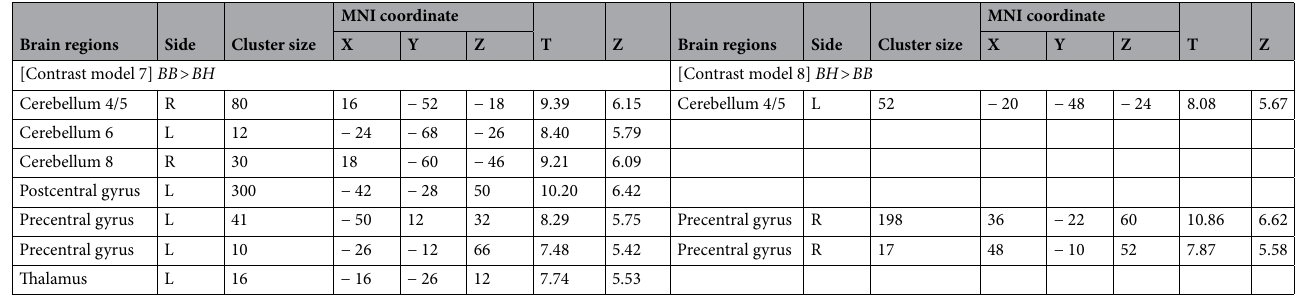
Table 3. MNI coordinates of results for contrast model 7 and 8. Row orders was sorted in alphabetical order with a few vacant rows to maximally visualize difference of two contrast models.